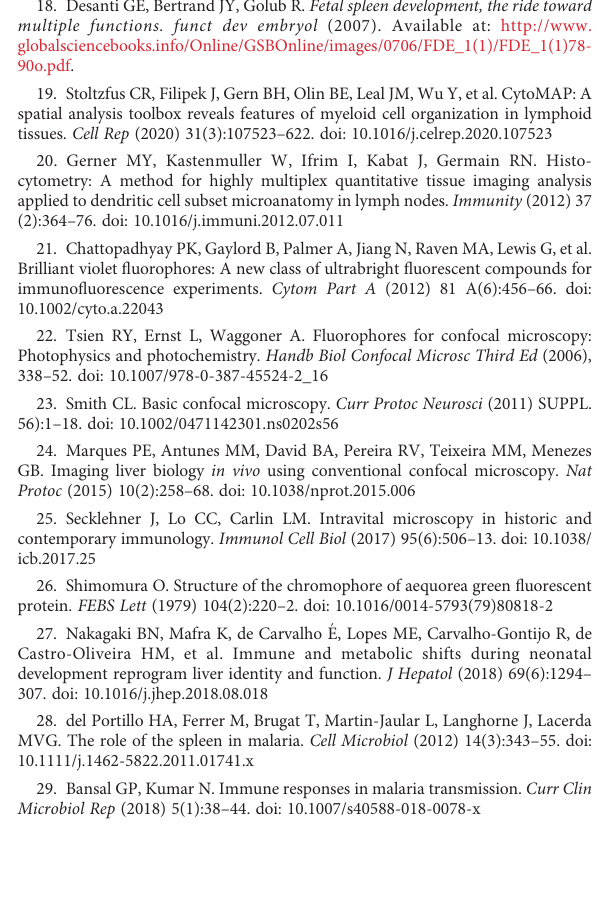
SUPPLEMENTARY VIDEO 1 Blood fl ow examination through fl uorescent albumin (FITC-conjugated) staining. Auto fl uorescence (blue); FITC-albumin (green). SUPPLEMENTARY VIDEO 2 Immune cells in splenic microenvironment from an 8-week mouse. Endothelial cells (anti-CD31, in blue), macrophages (anti F4-80, in green), monocytes (anti-Ly6C, in red), neutrophils (anti-Ly6G, in purple), B lymphocytes (anti-CD19,in white), NKcells (anti-NK1.1, in orange) andT lymphocytes (anti-CD3e, in magenta).